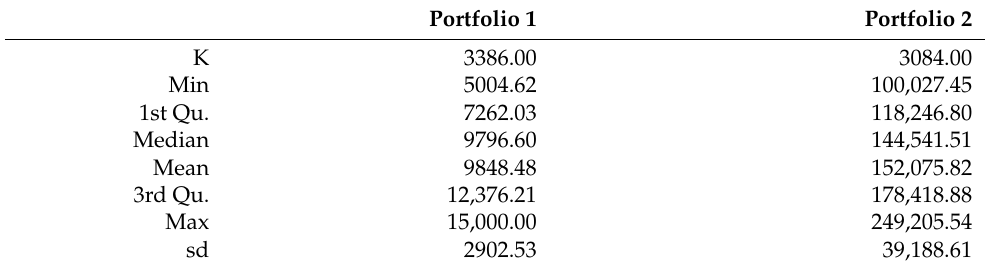
Table 10. Descriptive stats of the two